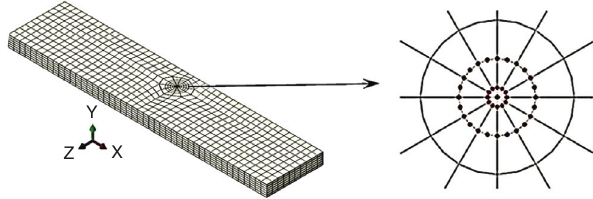
Figure 9 Shear surface of broken B21 specimen in cup and cone shape.